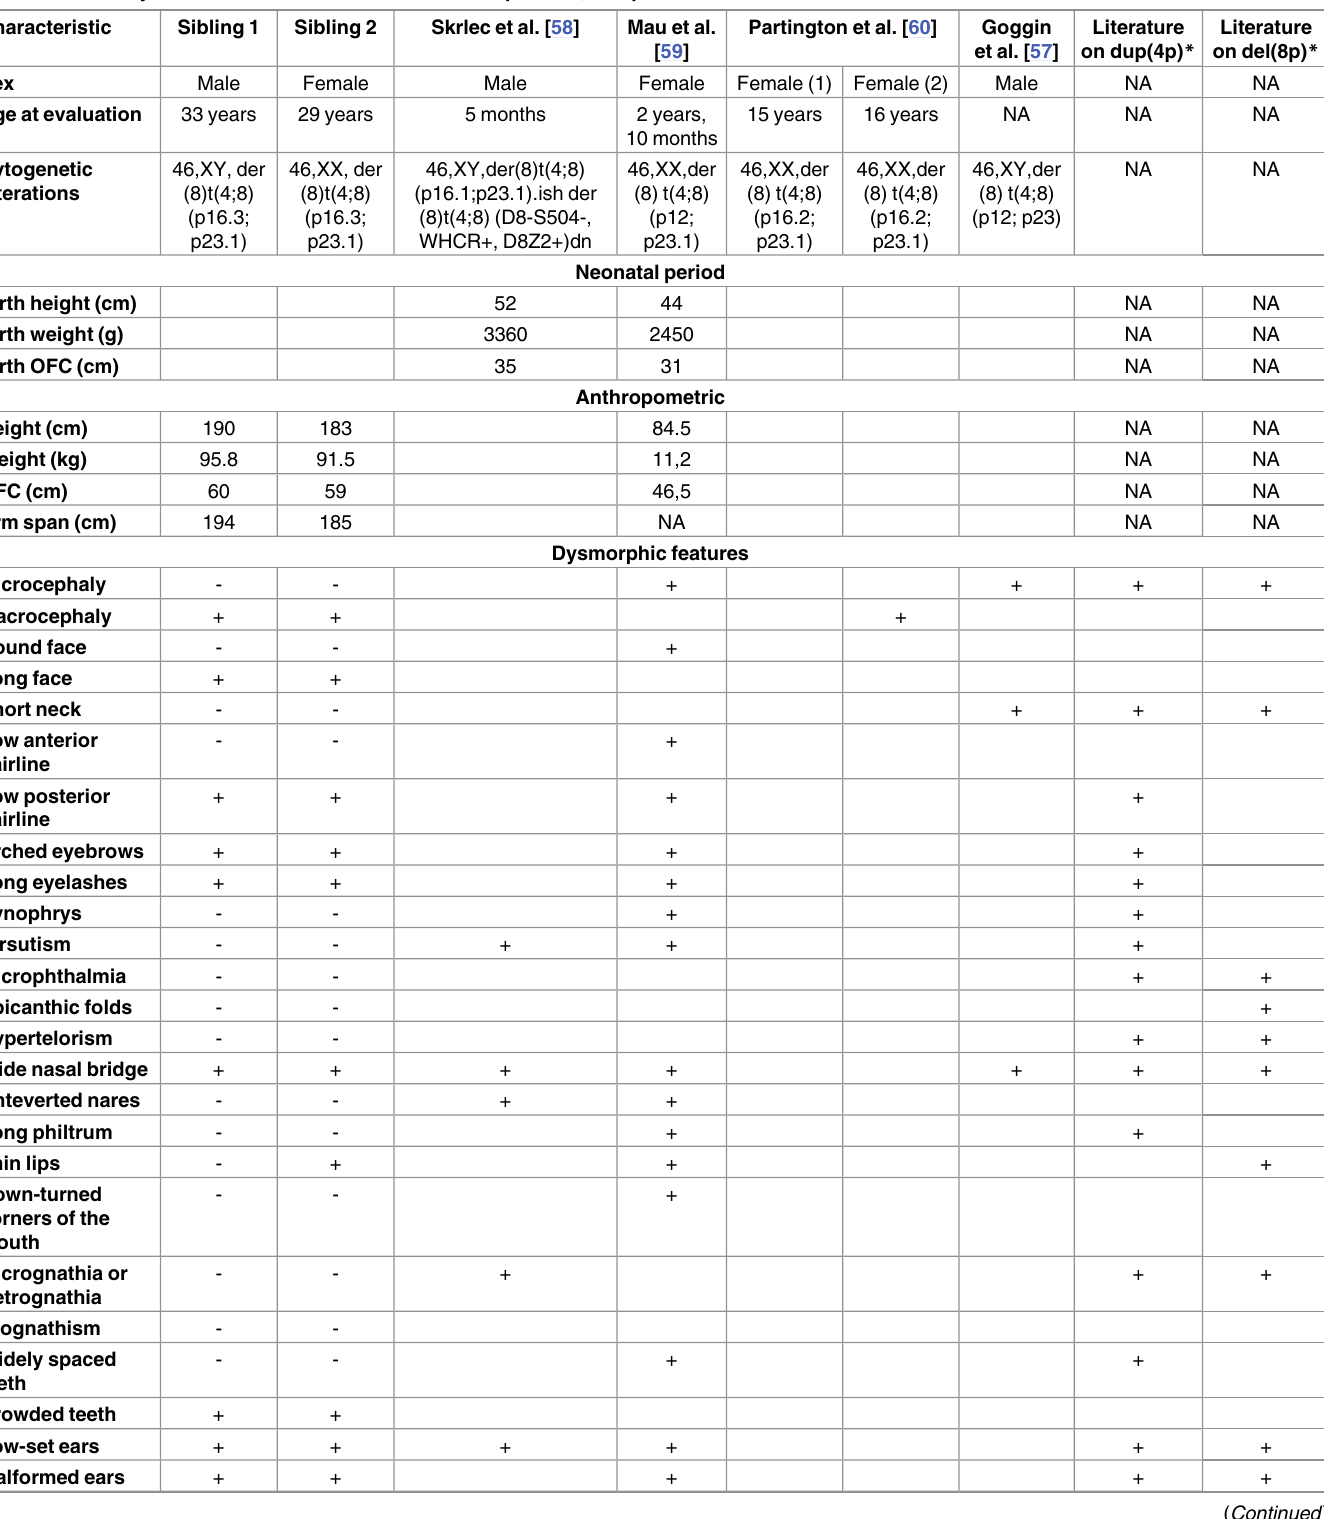
Table 1. Summaryof the characteristics observed in our patients, compared with those of other casesdescribed in the literature.